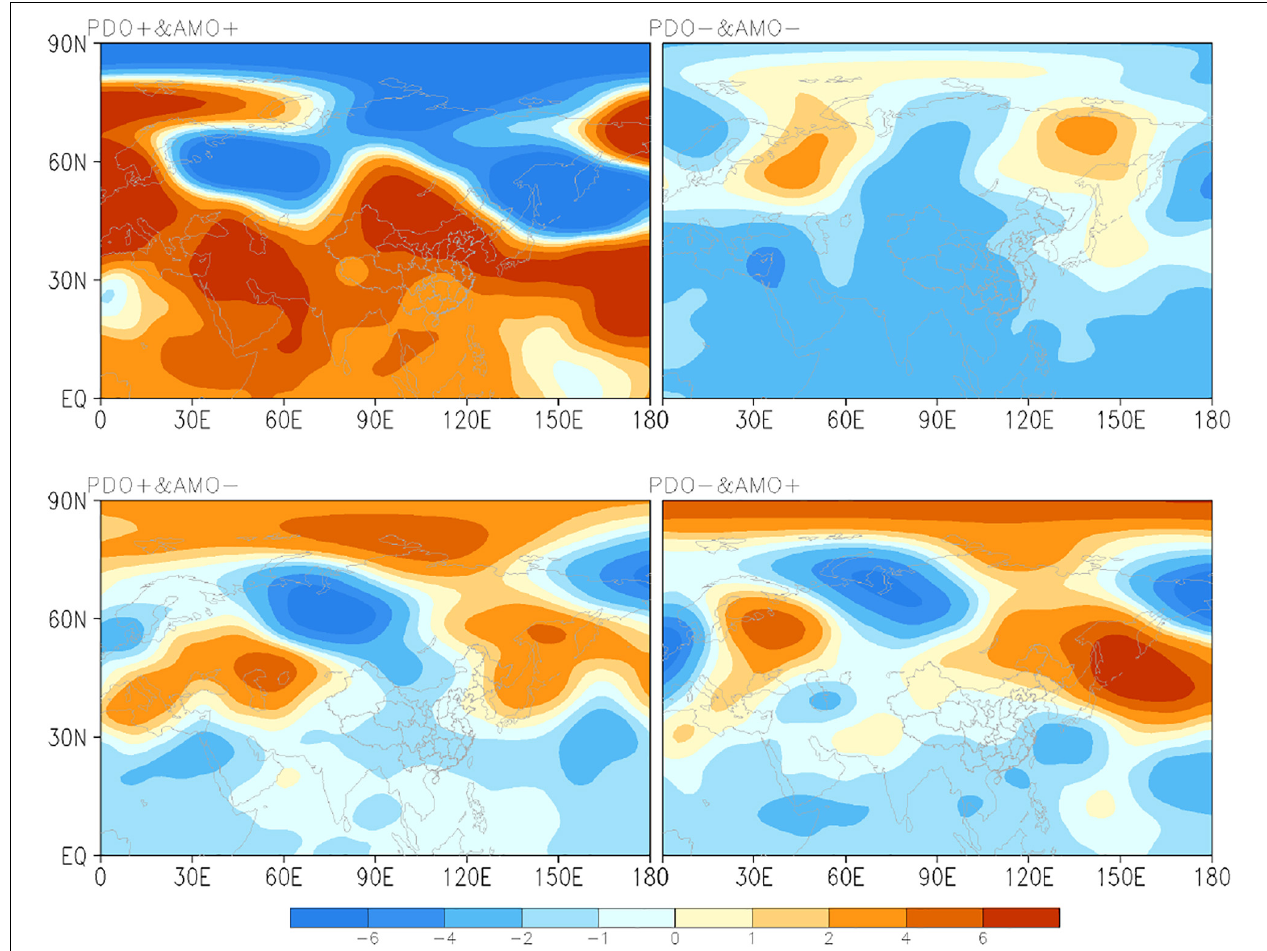
FIGURE 11 | The same as Figure 9 , but for the results after the low-pass